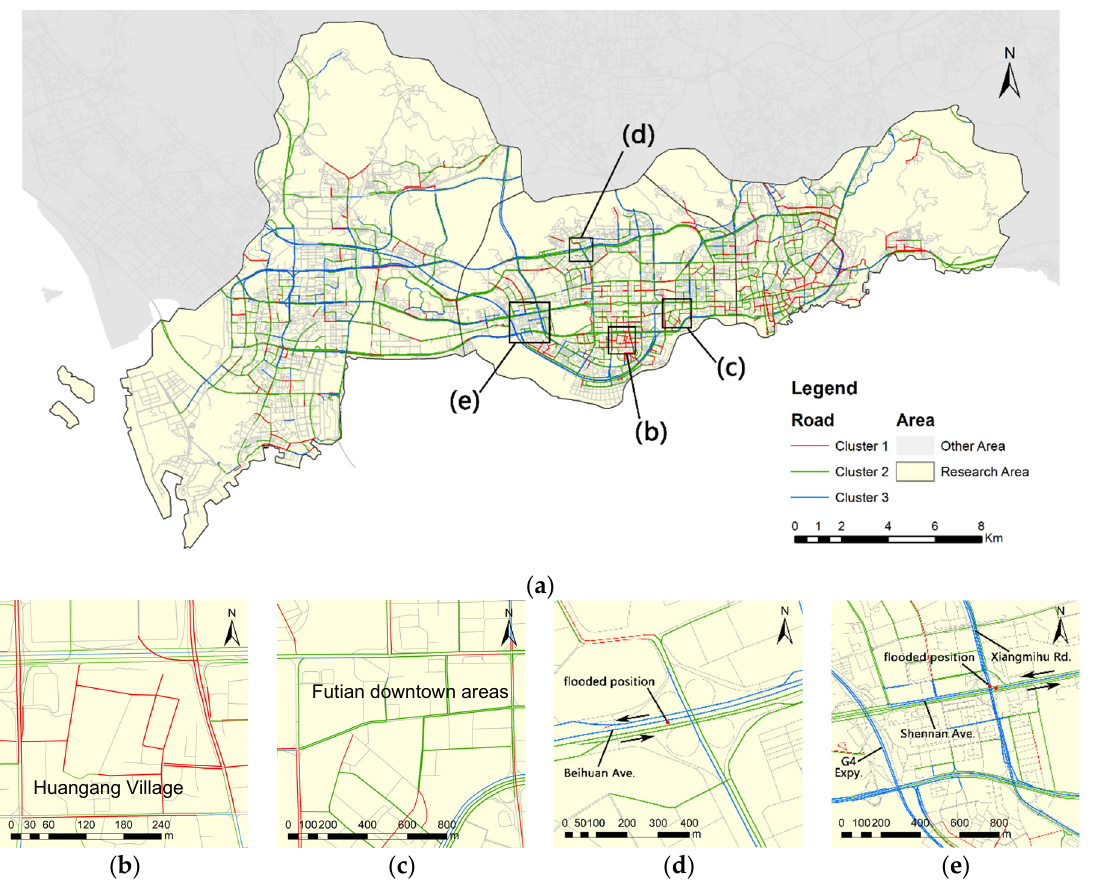
Figure 7. The spatial distribution of links of three clusters. ( a ) The spatial distribution of the links of the three clusters; ( b ) links near Huangang Village; ( c ) links in Futian downtown areas; ( d ) Beihuan Avenue is in cluster 2; ( e ) G4 Expressway and Xiangmihu Road are in cluster 3.